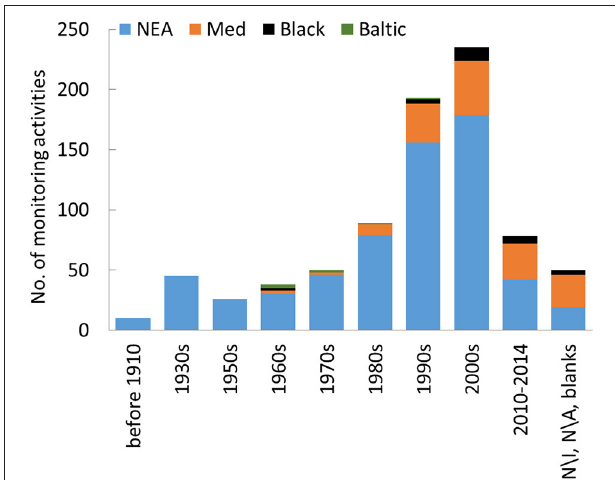
FIGURE 3 | Histogram showing the decades when monitoring activities started in the North Eastern Atlantic (NEA), Mediterranean Sea (Med), Black Sea (Black), and Baltic Sea (Baltic). N/I, not identified, N/A, not